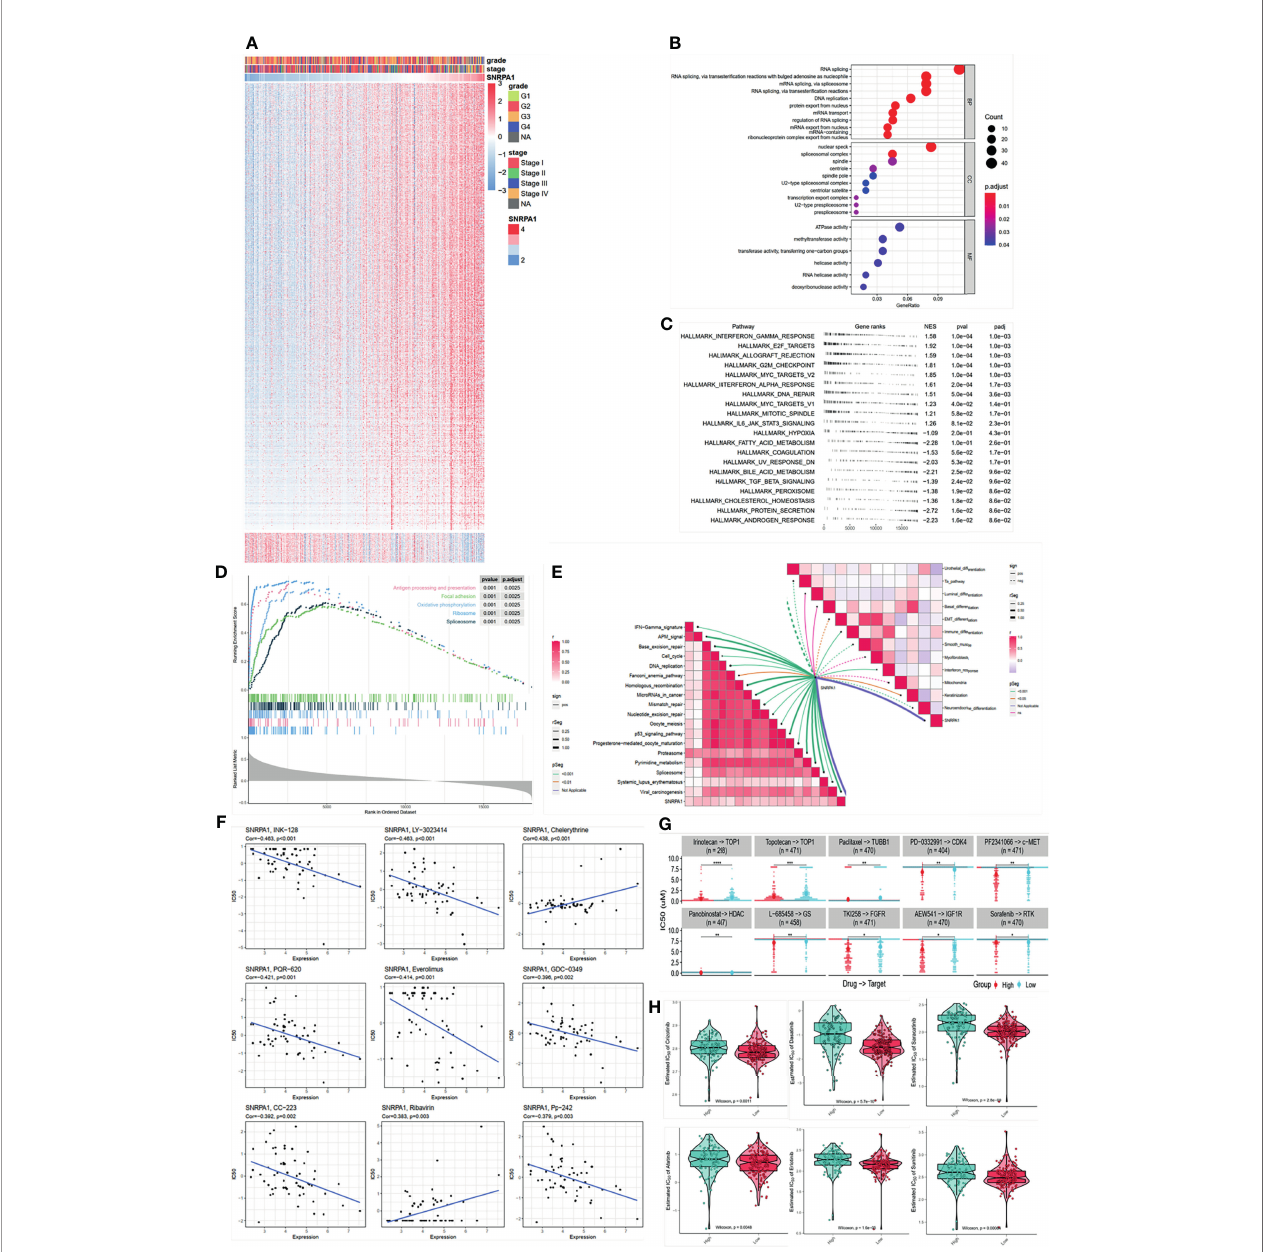
FIGURE 4 | SNRPA1 impacted signaling pathways and potential effective chemotherapy drugs. (A) Heatmap of SNRPA1 co-expressed genes in ccRCC patients. (B – D) GO, KEGG, and GSEA analyses of SNRPA1 in ccRCC. (E) Correlation of SNRPA1 expression level and urinary system carcinoma-related signature. (F) Correlation of SNRPA1 expression level and IC50 of different drugs obtained from the CellMiner database. (G) Different IC50 levels of drugs between SNRPA1 high- and low-expression groups obtained from the CCLE database. (H) Different IC50 levels of target drugs between SNRPA1 high- and low-expression groups based on the GDSC